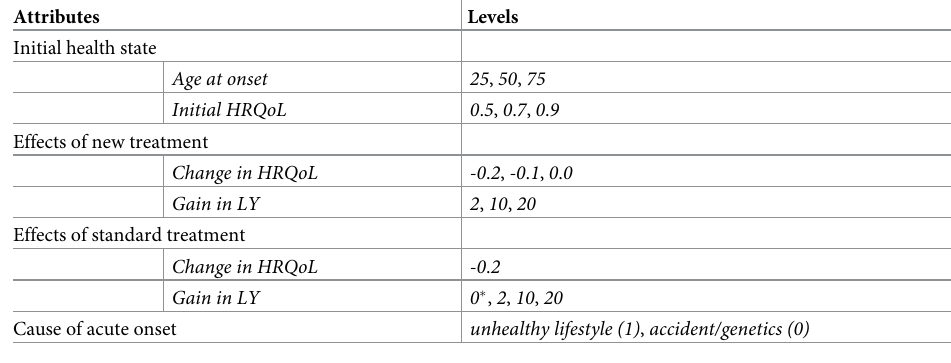
Table 1. Attributes and their corresponding levels used to describe criteria in the